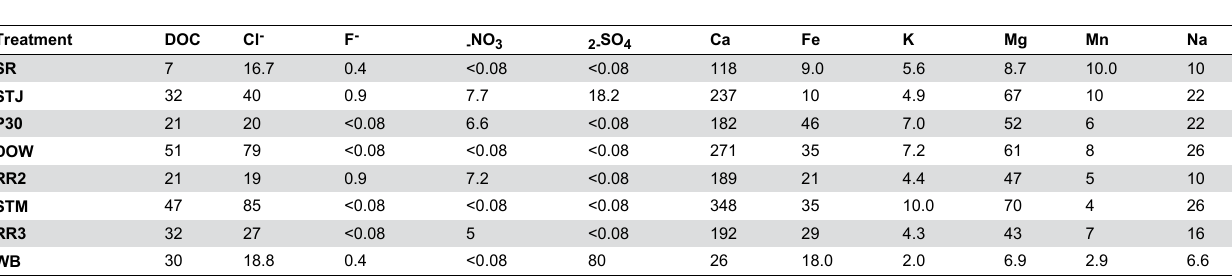
Table 2. Major constituents of pore waters from un-spiked sediments.